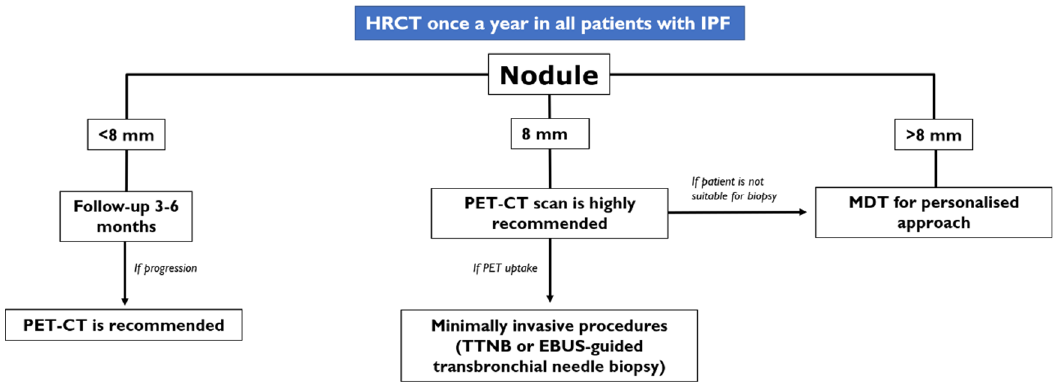
Figure 5. Management of a new nodule detected on follow-up HRCT, according to the approach suggested in the article published by Tzouvelekis et al. [35].